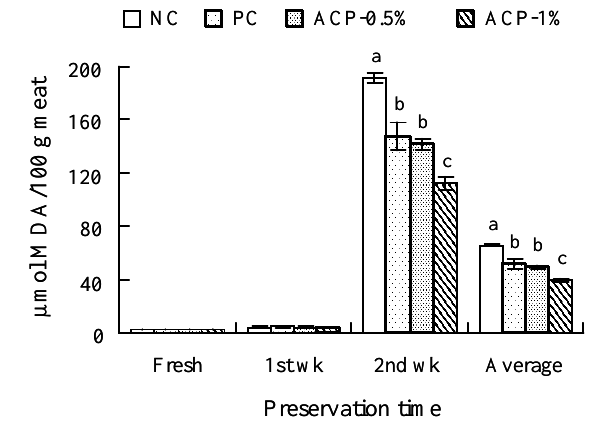
Figure 2. Effect of Alisma canaliculatum with probiotics on thiobarbituric acid reactive substance (TBARS) values of breast meat (n = 15 for each treatment). TBARS values are expressed as micromoles of malondialdehyde (MDA) per 100 g of meat. Data are presented as the mean  SE. Bars within a time class not sharing a common letter are significantly different (p<0.05). NC = Negative control (basal diet); PC = Positive control (basal diet with 0.005% Chlortetracycline); ACP = Alisma canaliculatum with probiotics.